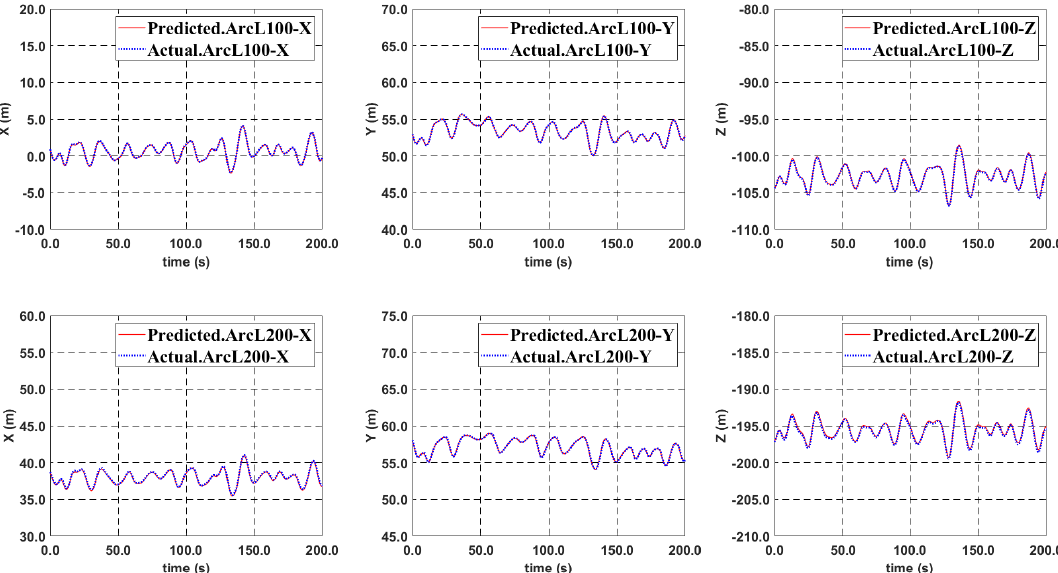
Figure 11. Displacement Tracing up to Target Point (200 m Arclength), 1-yr Storm ( Up ) and 100-yr Storm ( Down ), WD1000, SCR, Sensor Interval = 100 m.